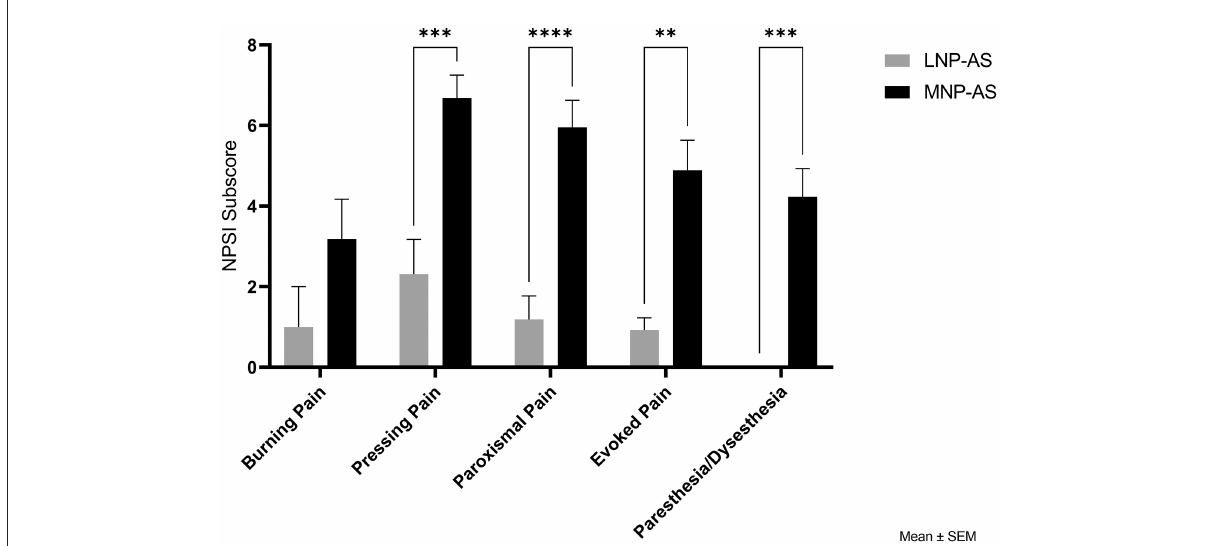
FIGURE4 Comparison of phenotypes with respect to NPSI subscores. NPSI, neuropathic pain symptom inventory; LNP-AS, low or no neuropathic pain-anxiety symptoms; MNP-AS, moderate neuropathic pain-anxiety symptoms. ** p < 0.01, *** p < 0.001, **** p < 0.0001.